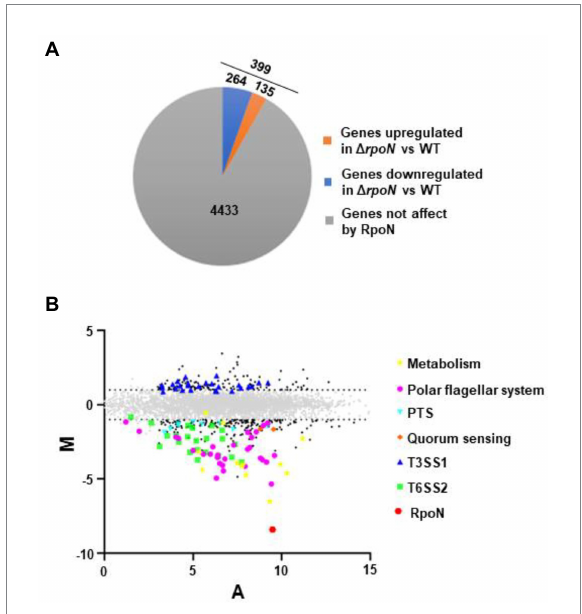
FIGURE 1 The regulon of RpoN in V. parahaemolyticus. (A) Pie charts show the genes whose expression significantly differed between Δ rpoN and WT strains in LB liquid medium. (B) MA plots showing changes that were observed in gene expression at Δ rpoN compared to WT. The genes associated with metabolism and virulence are highlighted. The log2 values for the ratios of abundances for each transcript are shown between Δ rpoN and WT (M, y axis) and plotted against the average log2 for abundance for that transcript under both conditions (A, x axis). Solid black dots, P adj <